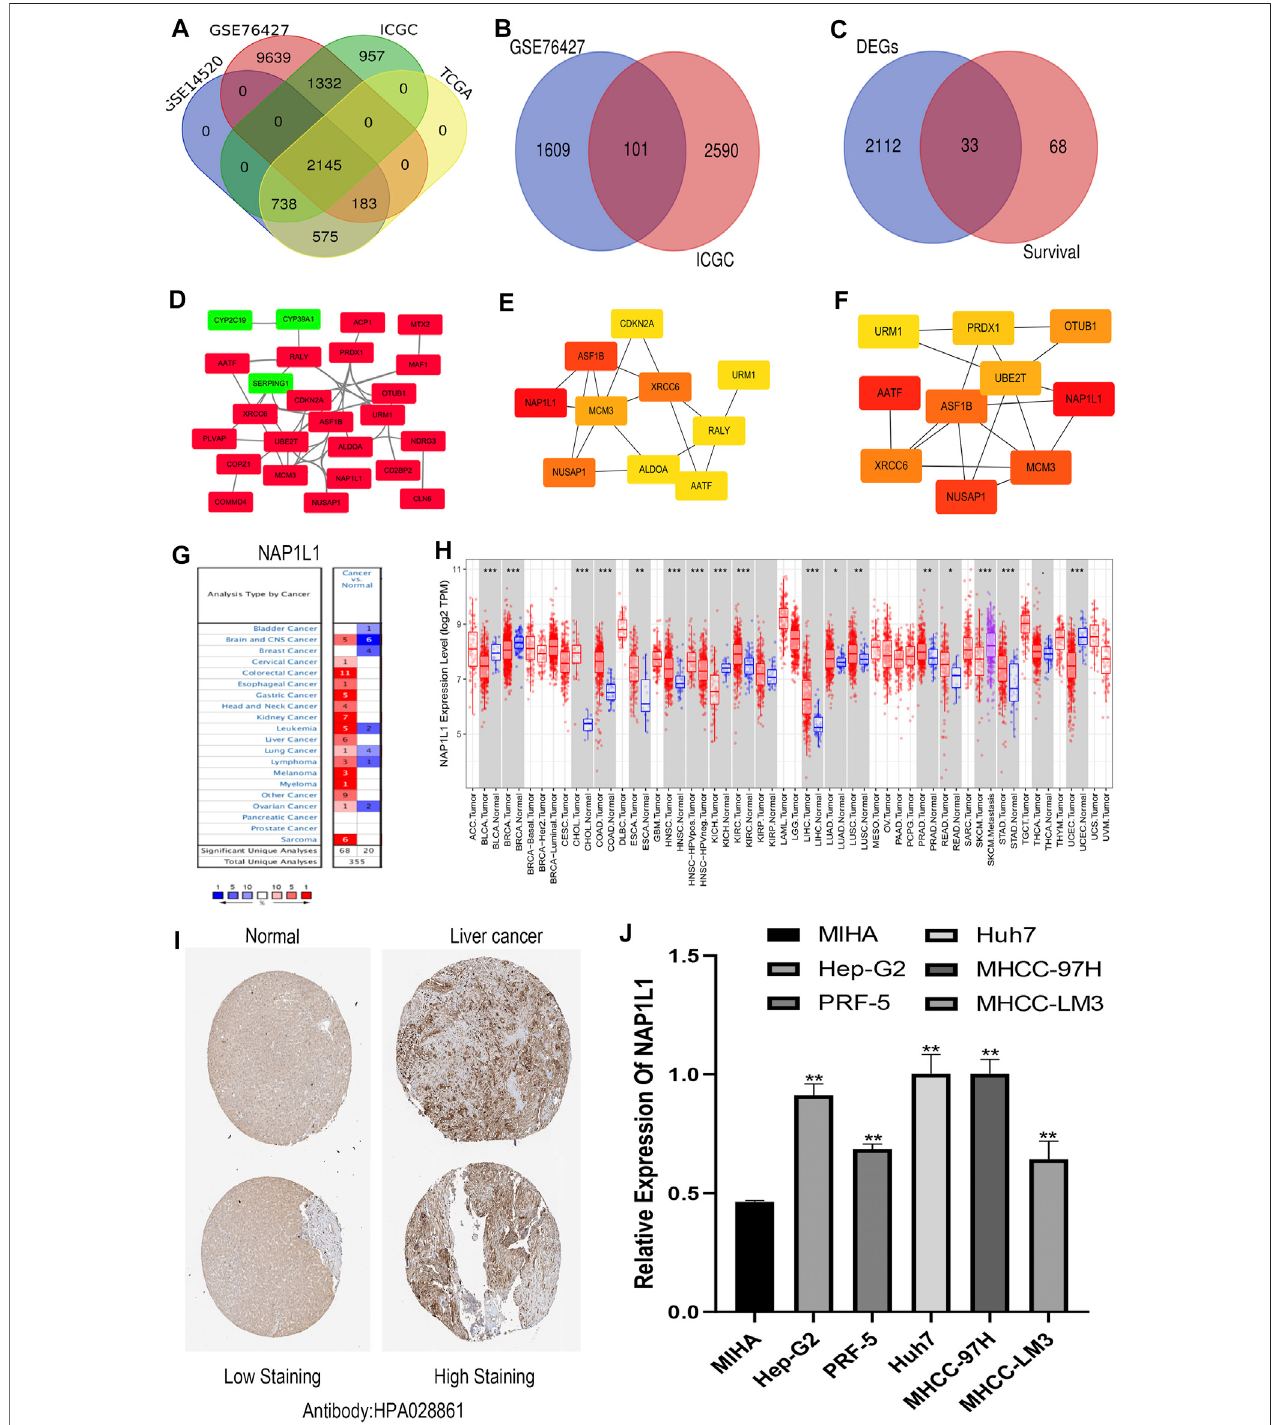
FIGURE 3 | Screening out the hub gene NAP1L1 , and NAP1L1 was up-regulated in HCC. (A) The identi fi cation of the 2,145 overlapping DEGs ground on GSE14520,GSE76427,ICGC, andTCGA. (B) Theidenti fi cationofthe101overlappingsurvival-relatedgenesgroundonGSE76427andTCGA. (C) Theidenti fi cationof the33commongenes. (D) ThePPInetworkwasconstructedusingthe33commongenes. (E) ThePPInetworkofthetop10hubgenes via DMNC. (F) ThePPInetwork of the top 10 hub genes via ClusteringCoef fi cient. (G) The expression of NAP1L1 applying the Oncomine database. (H) The expression of NAP1L1 applying the TIMER database (* p < 0.05; ** p < 0.01; *** p < 0.001). (I) The expression of NAP1L1 applying the HPA database. (J) The mRNA expression of NAP1L1 applying the RT-qPCR.